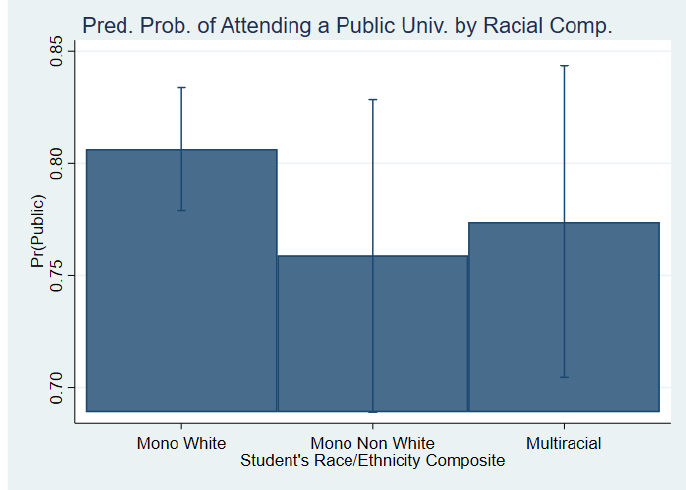
Figure 6. Pred. Prob. of Attending a Public School by Racial Comp. using Add Health data.